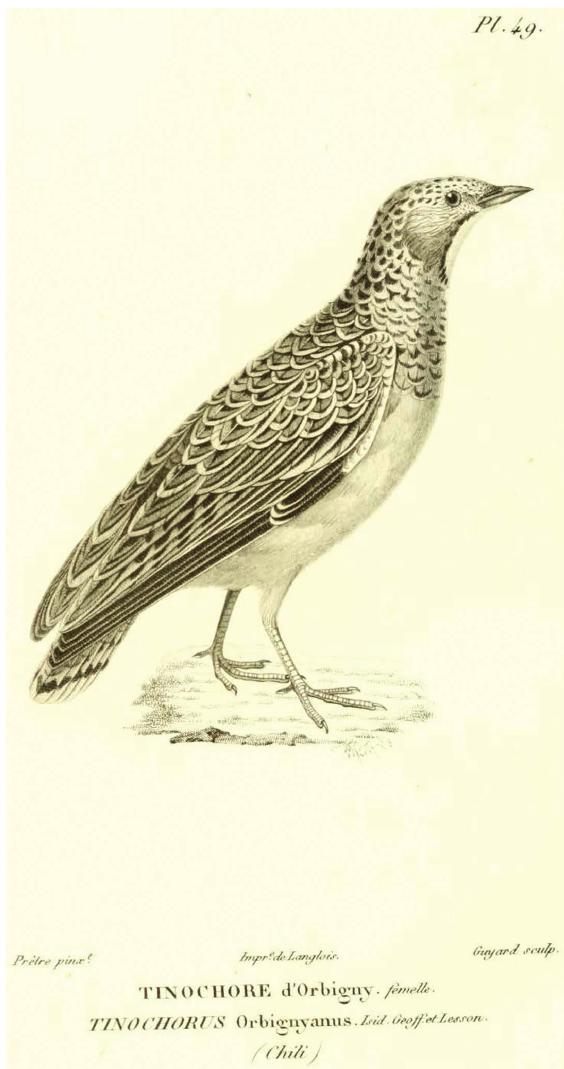
Figure 7: Thinocorus Orbignyianus (femelle), Lesson, Centurie zoologique , pl. 49.